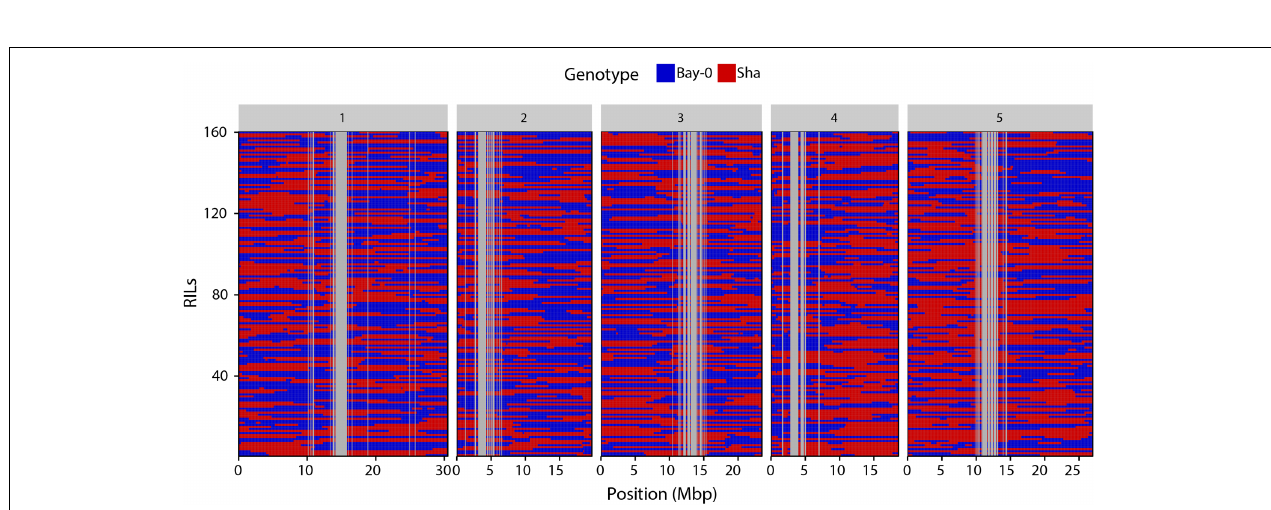
FIGURE 3 | Haplotype representation of the 160 RILs. Each row corresponds to a RIL. Columns represent the 1059 genetic markers physically anchored on the five chromosomes. Blue boxes indicate Bay-0 genotype and red boxes indicate Sha genotypes.